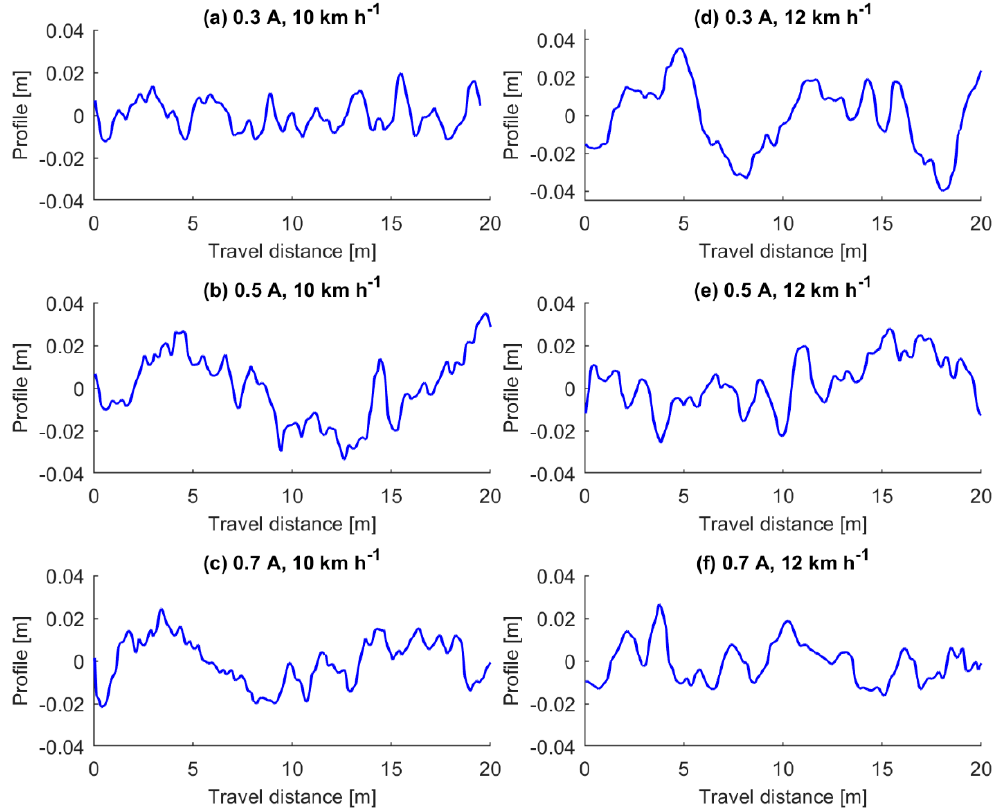
Figure 5. The measured vertical forces at the speed of ( a – c ) 10 km h − 1 and ( d – f ) 12 km h − 1 , when the MR damper was supplied with 0.3 A, 0.5 A, and 0.7 A.